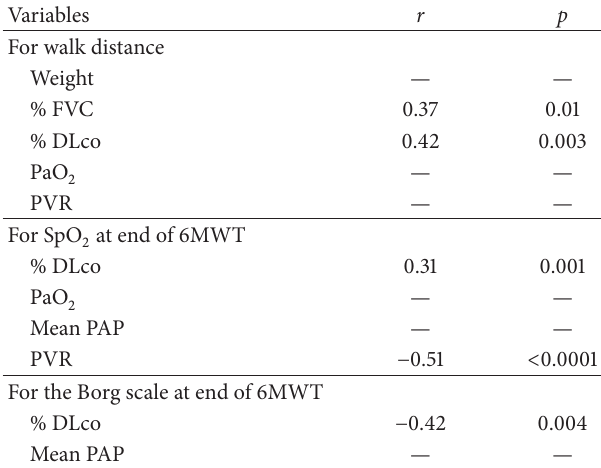
Table 4: Results of stepwise multiple regression analysis for walk distance and SpO 2 and the Borg scale at end of 6 min walk